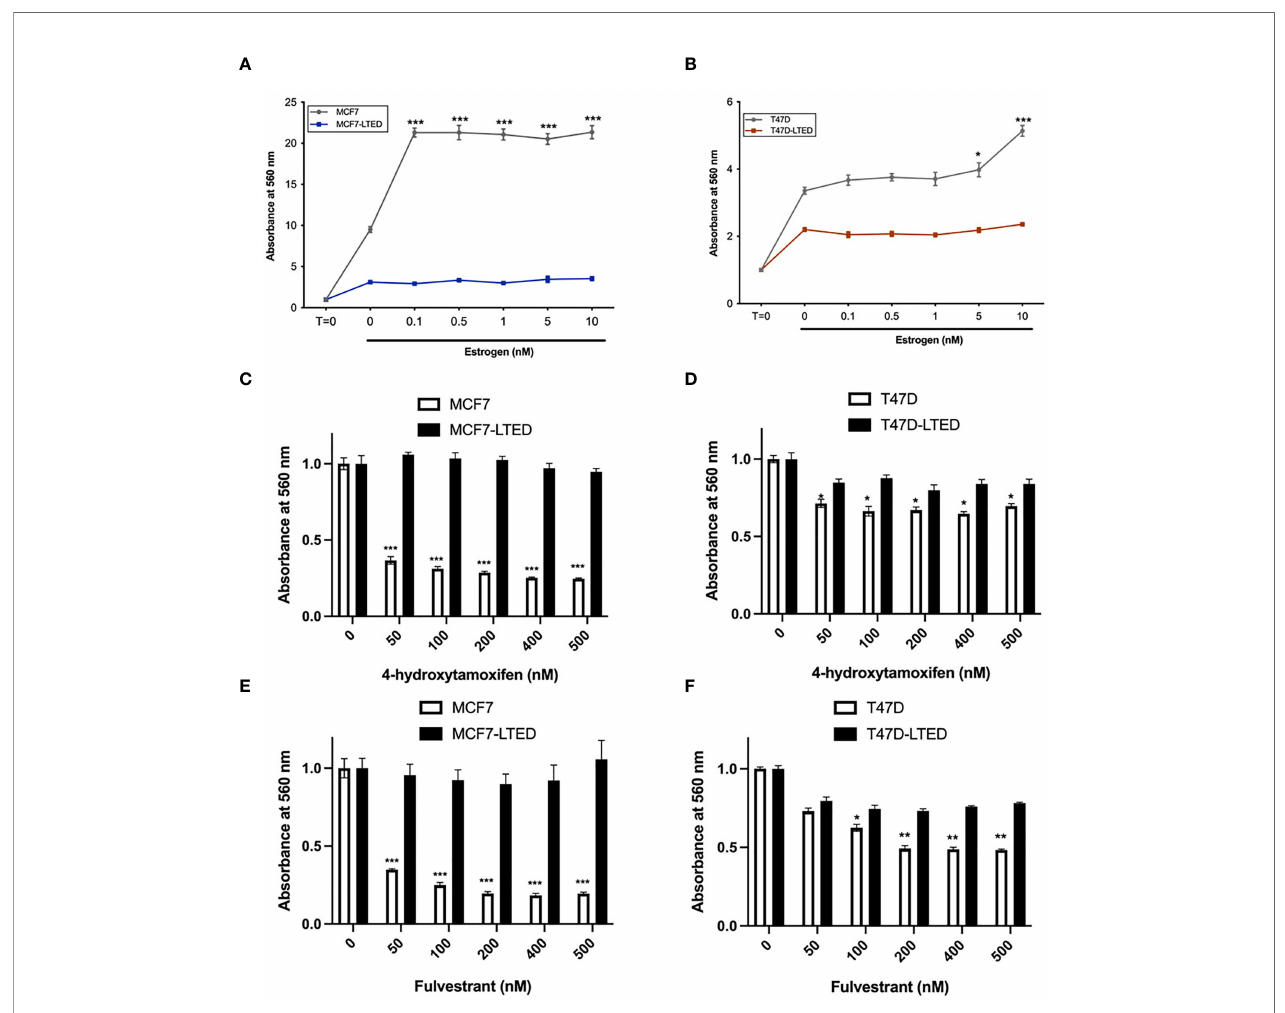
FIGURE 1 | LTED cells are resistant to antiestrogens. (A – F) Parental cells (MCF7 and T47D) and their derivatives (MCF7-LTED and T47D-LTED) were treated with vehicle or increasing concentration of estrogen (17-estradiol; E2), tamoxifen (4-hydroxytamoxifen) or fulvestrant for 6 days (media was replenished at 72 h). Cell number was measured by crystal violet assays in 96-wells; absorbance was read at 560 nm. Points represent the mean±SE of relative number (normalized to t=0 for estrogen and 0 nM for 4-hydroxytamoxifen and fulvestrant) for a single representative experiment performed in sextuplicate. *p < 0.05, **p < 0.01 and ***p < 0.001 (ANOVA) for cell number cell number at indicated drug concentrations compared with 0 nM for indicated cell lines. Data presented here is representation of three independent